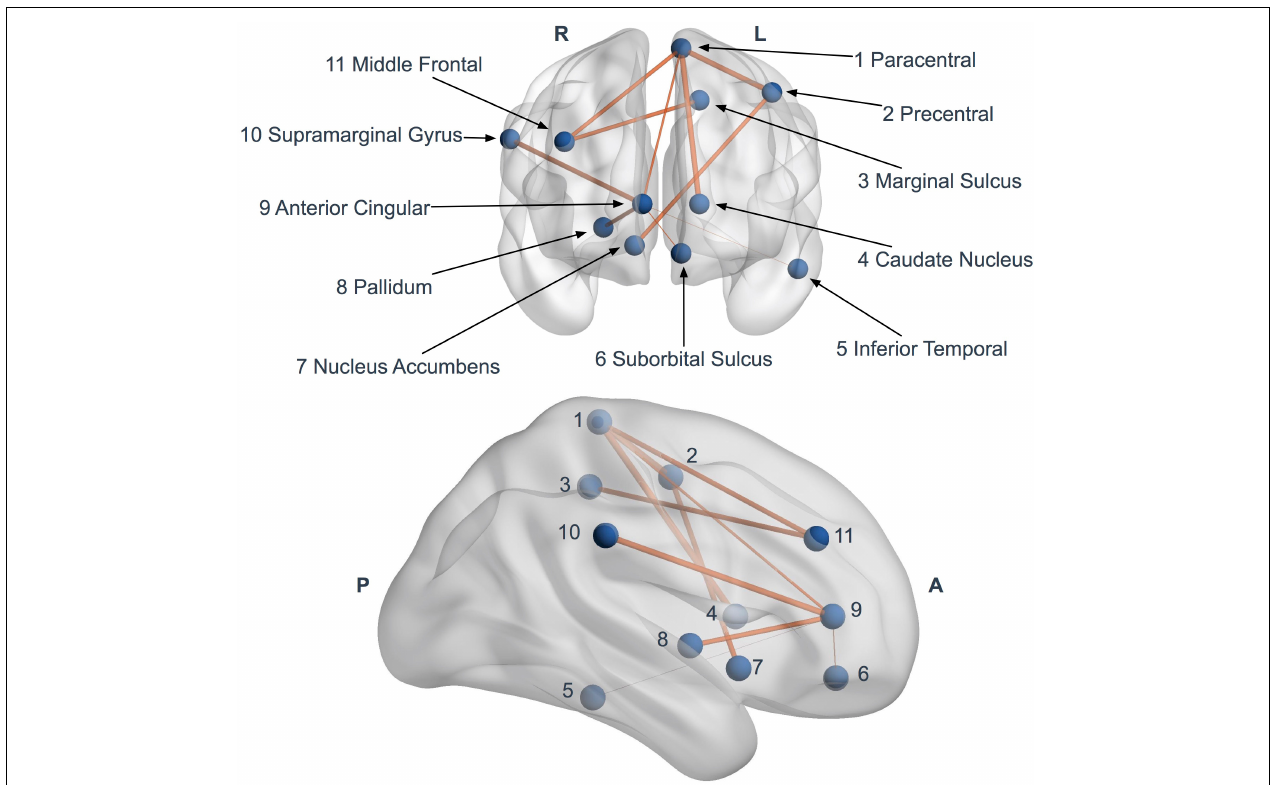
FIGURE 5 | Network based statistics (NBS) impaired subnetwork. Coronal and sagittal views of impaired subnetwork nodes and interconnections identified by NBS (11 nodes and 10 edges). Edge diameter is based on the FA reduction (the larger connections are the more affected, with significant FA